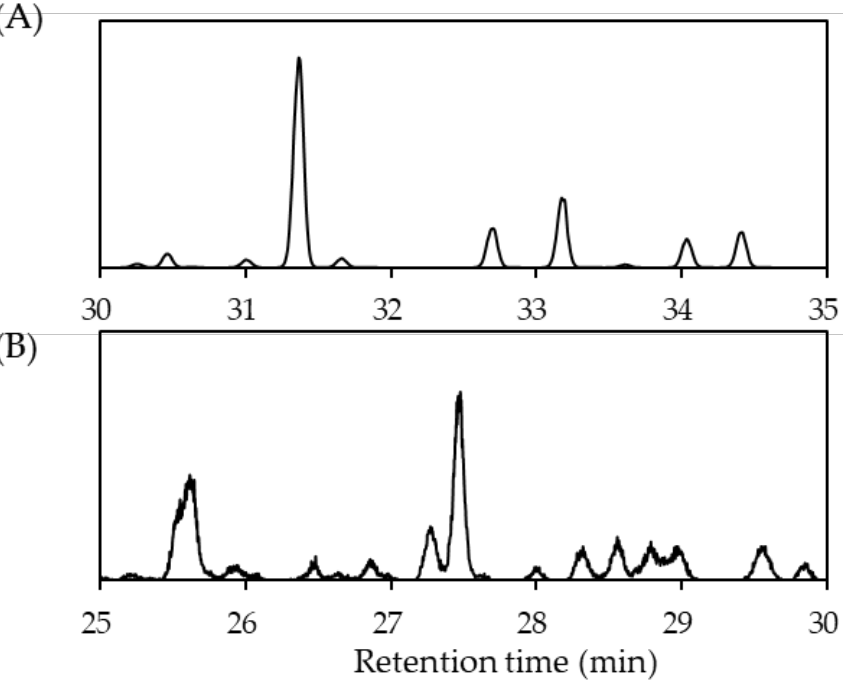
Figure 2. Chromatogram result for ( A ) H0-DBT; and ( B ) H18-DBT. The refractive index varies linearly with the degree of hydrogenation [36,40]. The refractive index was measured using the Nova-tech (Kingwood, TX, USA) Abbe refrac- tometer VEE GEE model C10 within a measurement range of 1.3000–1.7000 nD, with a resolution of 0.0005 nD and an accuracy of 0.0003 nD. Moreover, the density of H0-DBT